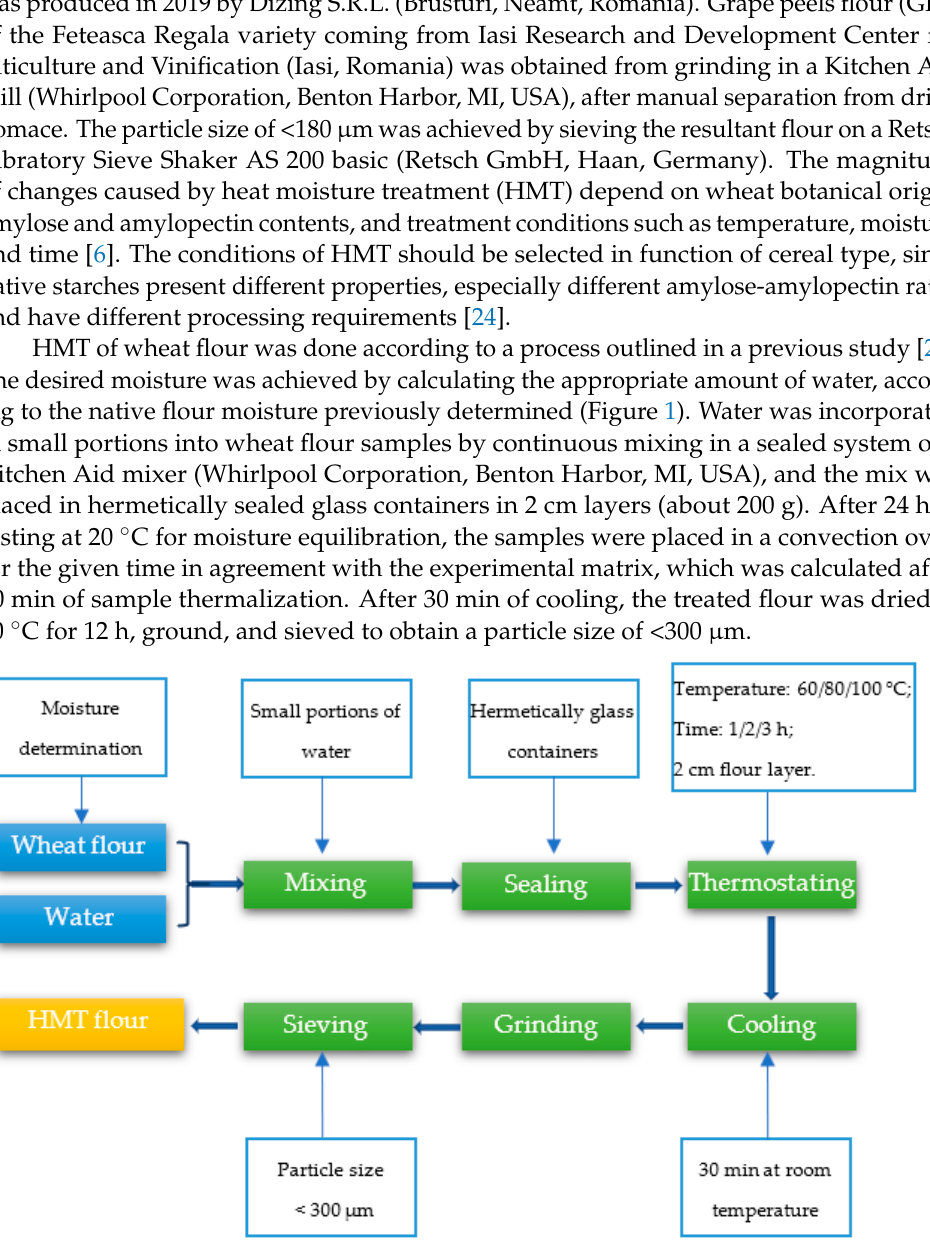
Figure 1. Heat moisture treatment (HMT) graphical representation.